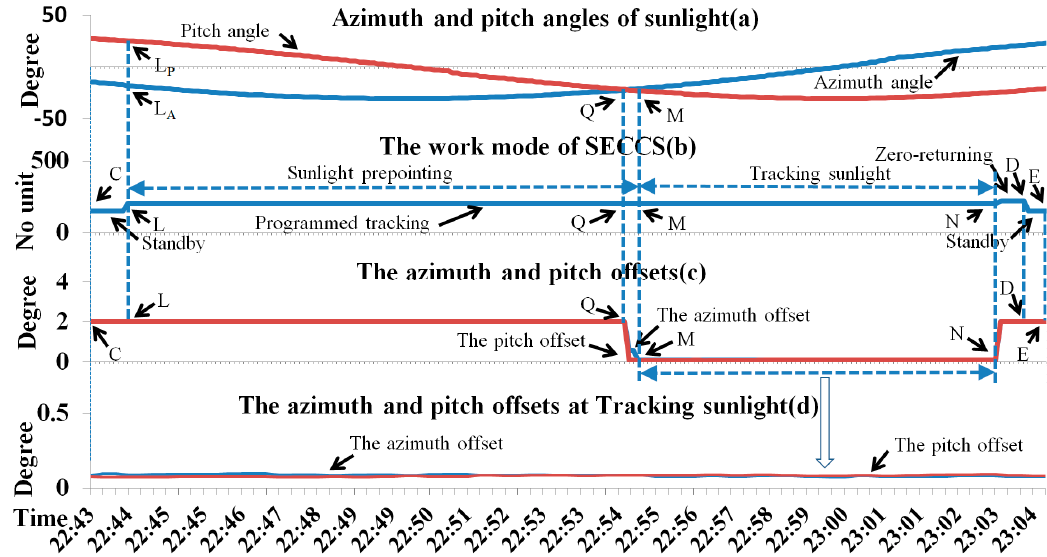
Figure 6. The work mode and angle in the fi rst orbit using the alternative method.